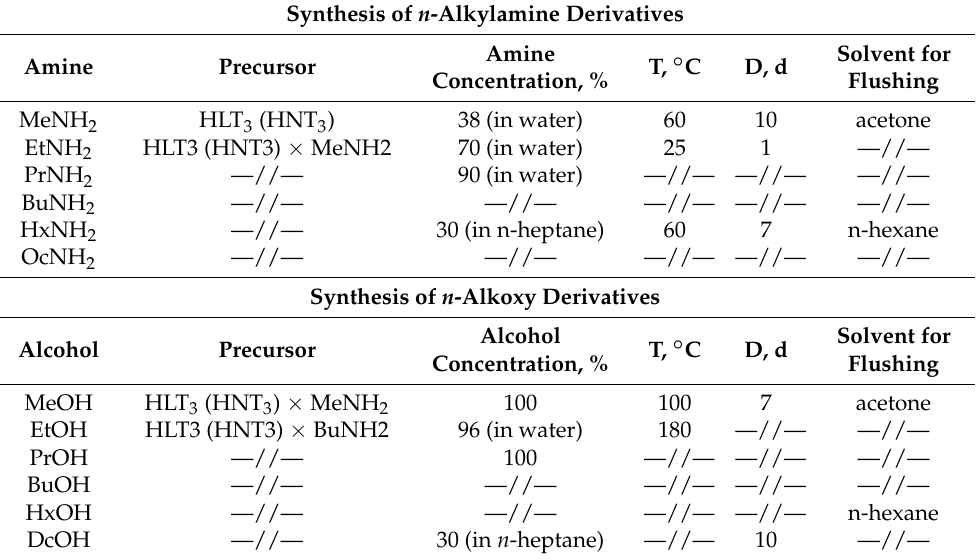
Table 5. Conditions for synthesis of inorganic-organic